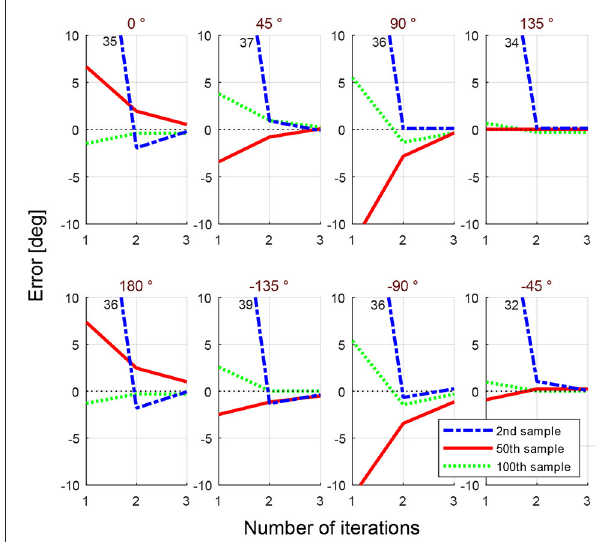
FIGURE 4 | Error in eight desired angles for three selected samples during the training. Each sample corresponds to a point in the workspace. Blue lines show the optimization for the 2nd random starting position, red lines for the 50th, and green lines for the 100th randomly selected sample. Through iteration, using (12), the error is reduced to reach an acceptable